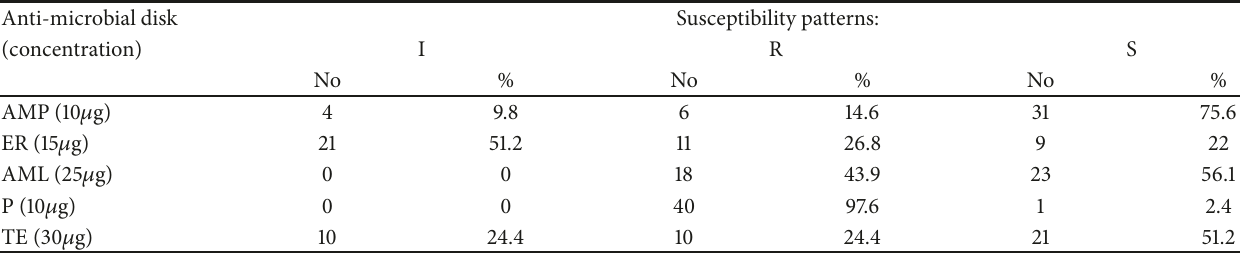
Table 7: Antimicrobial susceptibility test profiles of S. aureus isolates (n=41). Anti-microbial disk